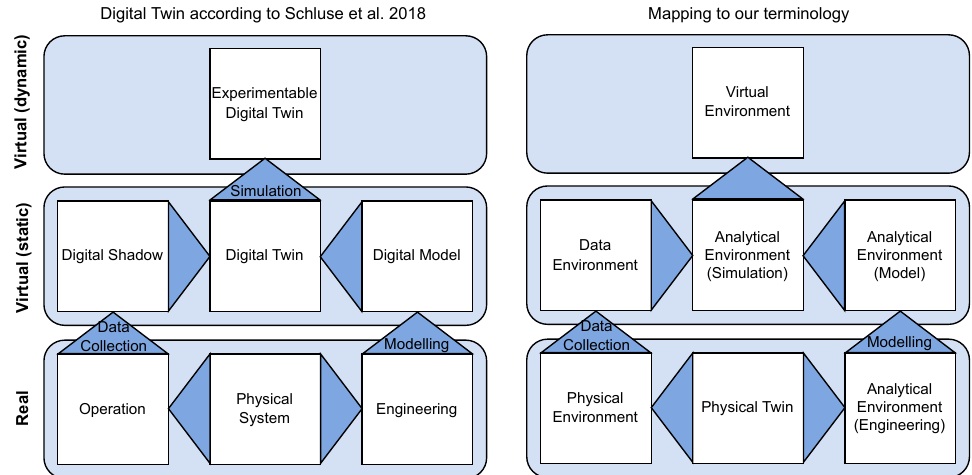
Figure 8. Digital Shadows and Digital Models in the context of Digital Twins . The left side demonstrates the relations between a Digital Shadow, a digital model and a DT [152]. The right side demonstrates the mapping to our definition. The Digital Shadow corresponds to the Data Environment and relies on the Physical Environment to collect data. The Engineering, Digital Model and their DT simulation correspond to the Analytical Environment. The experimentable DT is akin to the Virtual Environment. In our definition, all blocks are components of the DT, whereas in the other definition, the DT is a piece in the diagram. The reduction of the DT to a simulation removes the HCI from the system and requires terms such as Digital Shadow and Digital Models to differentiate